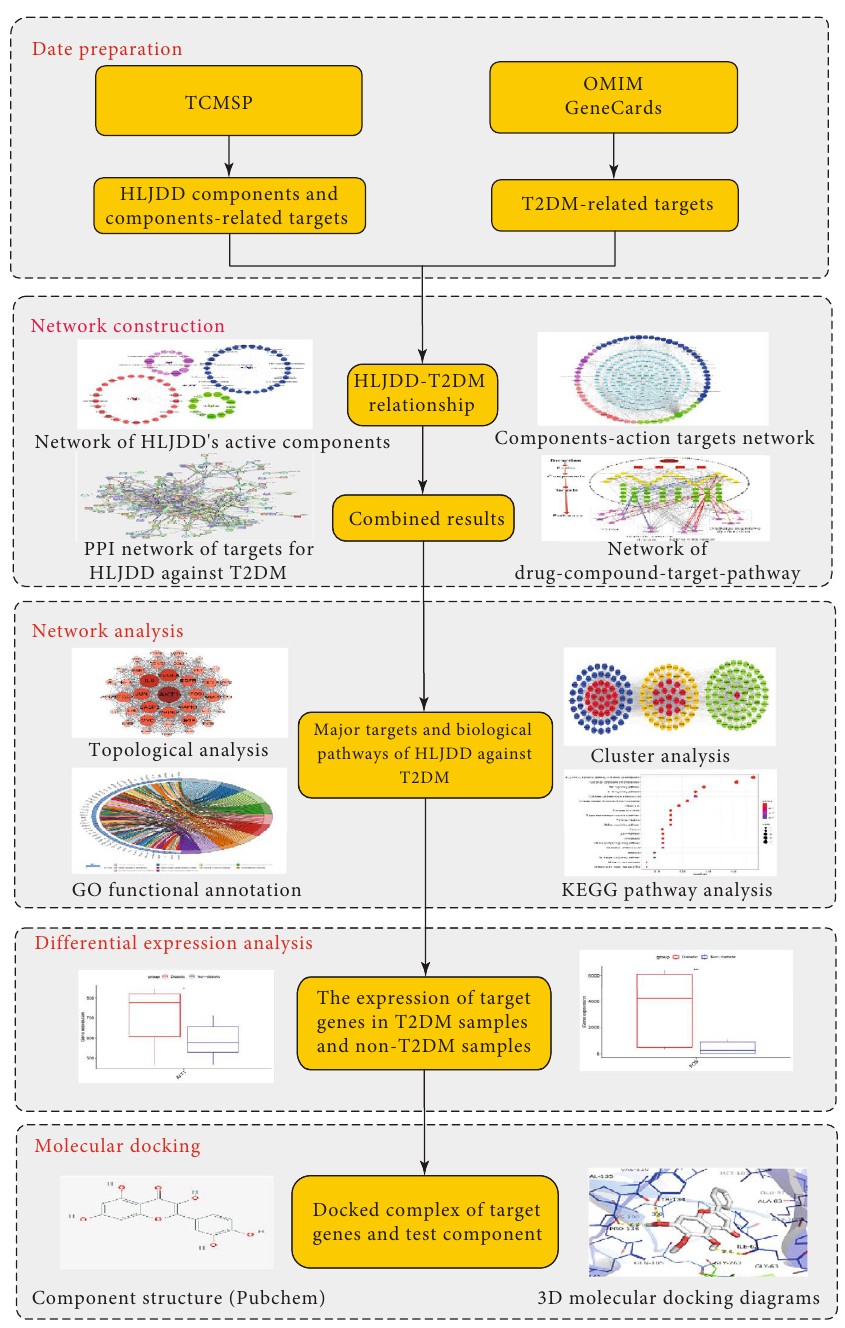
Figure 1: Work fl ow for HLJDD in the treatment of